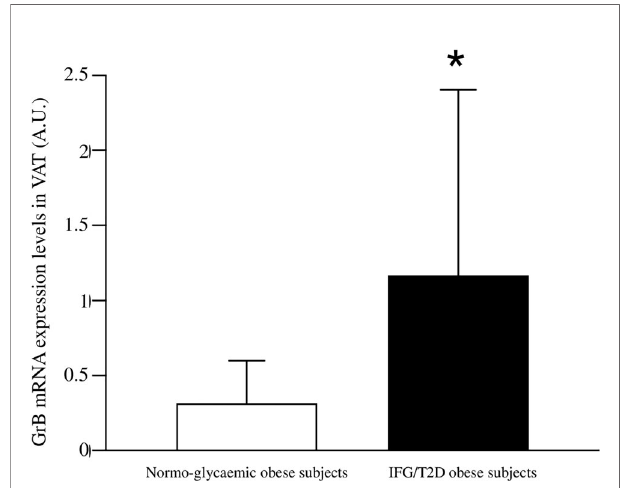
FIGURE 1 | Comparison between Granzyme B (GrB) expression in visceral adipose tissue (VAT) from normo-glycemic obese subjects (n= 62) and IFG/T2D obese subjects (n=23). GrB mRNA expression levels are shown as arbitrary units (A.U.). Data are shown as mean ± standard deviation. *p <